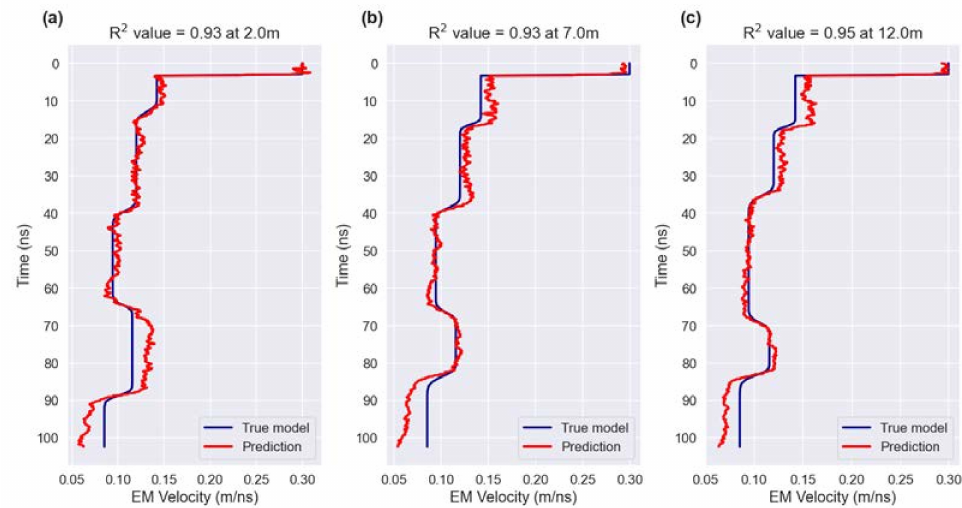
Figure 7. ( a – c ) show the matching results of three selected velocity models at different offsets (Figure 6a) with corresponding DCNNs based inverted velocity models (Figure